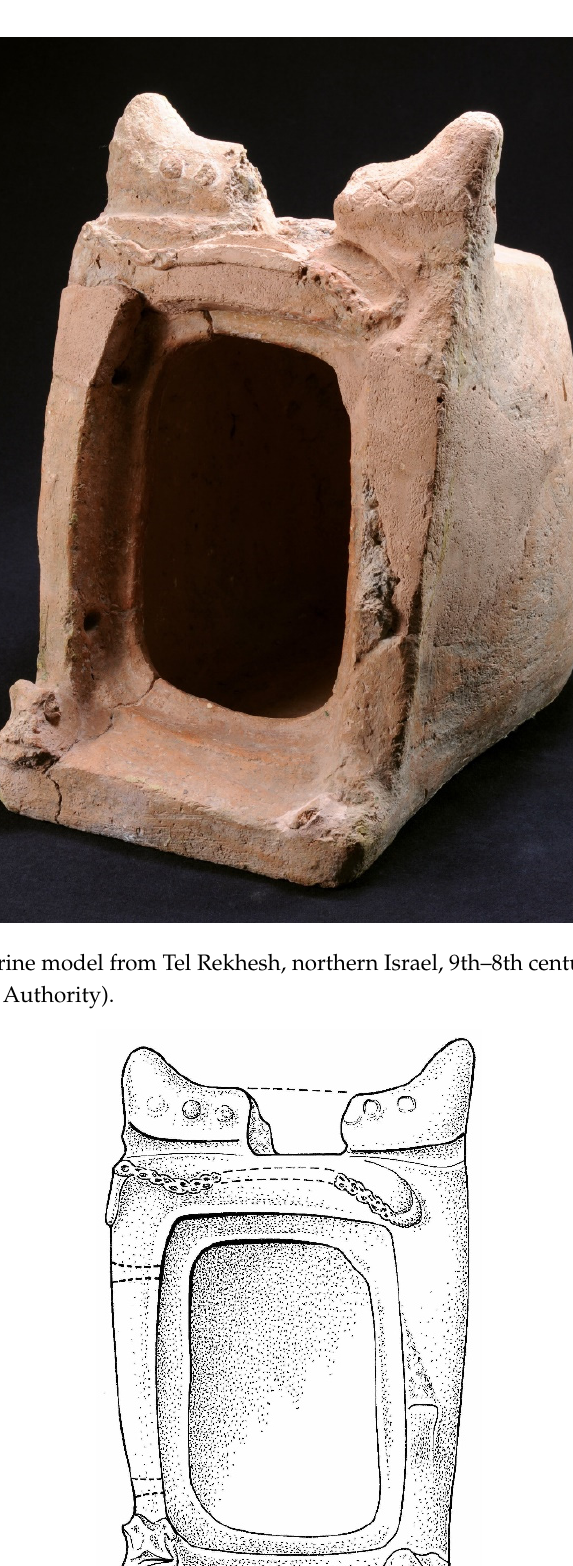
Figure 13. Drawing of the upper part of the portable shrine from Tell el-Far‘ah North, emphasizing the folded curtain.